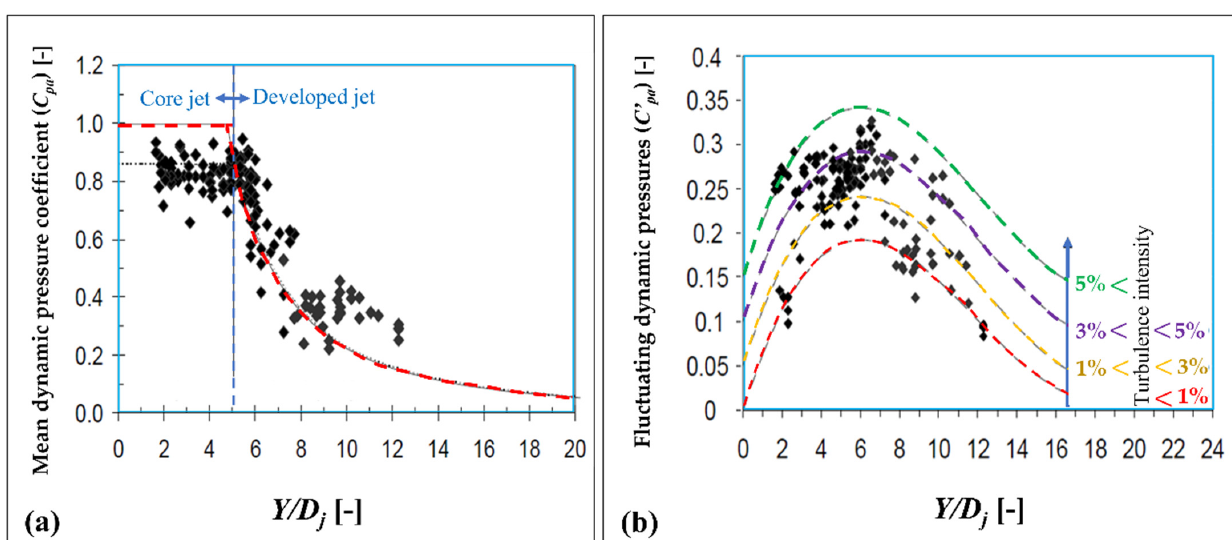
Figure 9. ( a ) Diversity of the mean dynamic pressure coefficient (along the jet centre line) as a performance of the dimensionless ratio of Y [55]; ( b ) nondimensional root-mean-square dynamic pressure coefficient for jet velocities higher than 20 m/s [62].